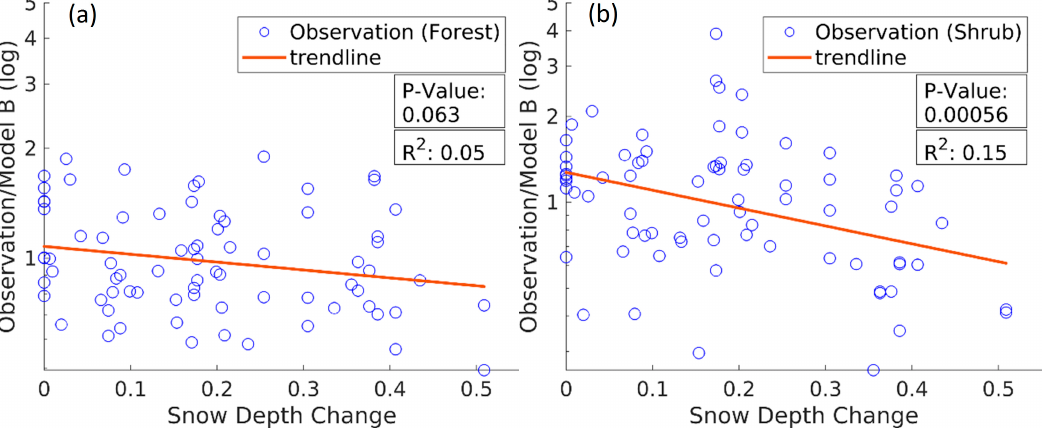
Figure 6. Semi-logarithmic scatter plot of the coherence ratio, i.e., observation/model B, versus snow depth changes (meter) for forested ( a ) and shrub ( b ) land cover types.